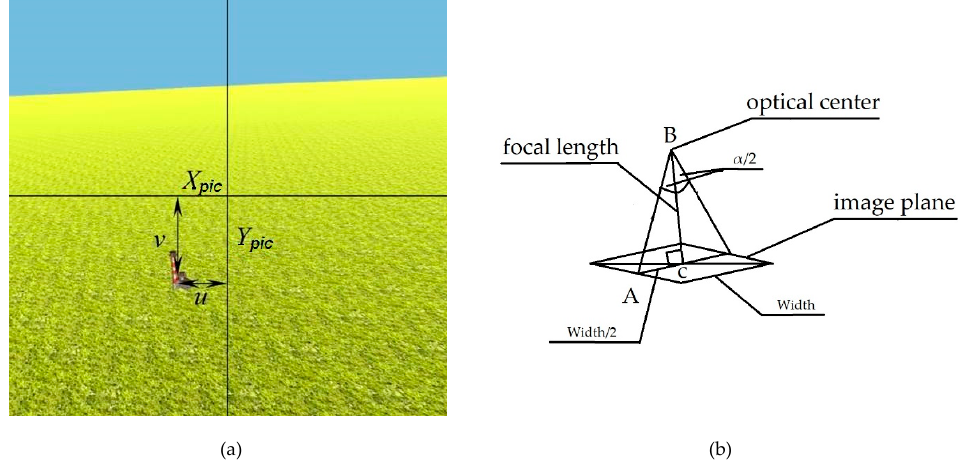
Figure 4. ( a ) Horizontal and vertical coordinates u and v of the object origin projection in a large image, ( b ) camera schema.